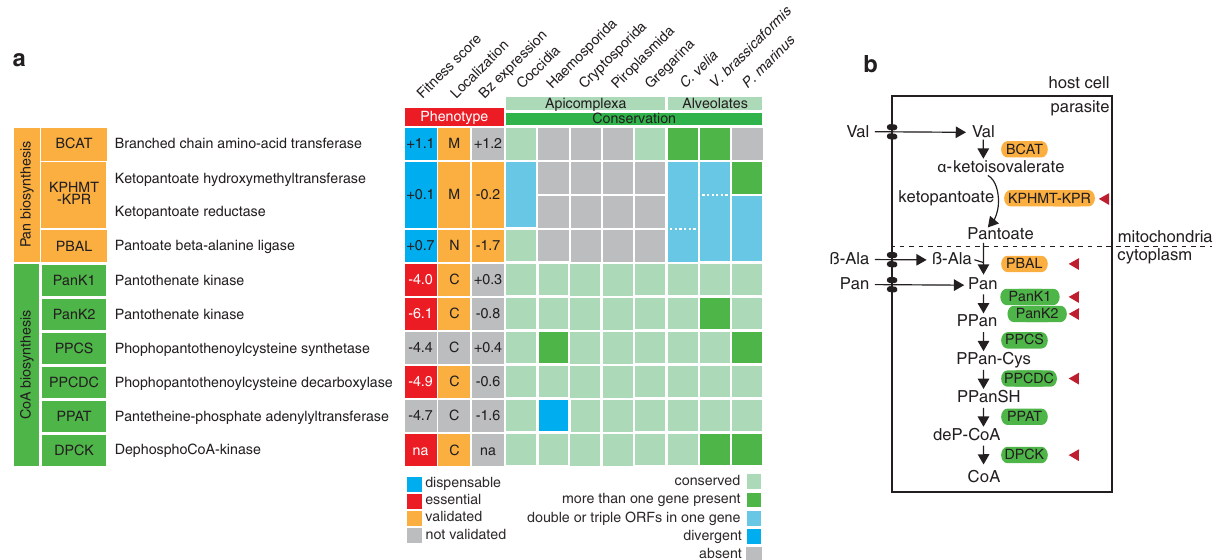
Fig. 1 Pan and CoA biosynthesis pathways in T. gondii . a Table representing the fi tness cost, localization, and stage expression of enzymes for pantothenate and coenzyme A biosynthesis in T. gondii , and conservation of the genes in other alveolates. Fitness scores from a genome-wide fi tness screen are given (positive values indicate dispensability, while negative values suggest essentiality) 15 , together with dispensability/essentiality determined from this and previous studies (blue - dispensable, red - essential). Localizations, experimentally determined in this or previous studies, are given for all enzymes involved in pantothenate (Pan) or coenzyme A (CoA) biosynthesis (M mitochondrion, N nucleus, C cytosol), in gray when predicted but not experimentally validated. Log 2 fold change in RNA levels from an RNA-seq analysis 75 are provided (bradyzoite (Bz) expression levels relative to tachyzoites) and complemented by protein expression levels determined in this study (orange – validated experimentally). Conservation is determined by a BLAST search (e-value < E − 04). Dotted lines represent the situation where single/fused genes are present, as well as one open reading frame (ORF) spanning all 3 genes. b Cartoon scheme of the Pan and CoA biosynthesis pathways. Valine (Val), β -Alanine ( β -Ala) and Pan are likely salvaged through unknown transporters. Enzymes are in boxes. Red arrowheads highlight the enzymes under scrutiny in this manuscript. Abbreviations: PPan, 4 ′ - phosphopantothenate; PPan-Cys, 4 ′ -phospho-N-pantothenoyl cysteine; PPanSH, 4 ′ -phosphopantetheine; deP-CoA, dephospho-CoA; CoA, coenzyme